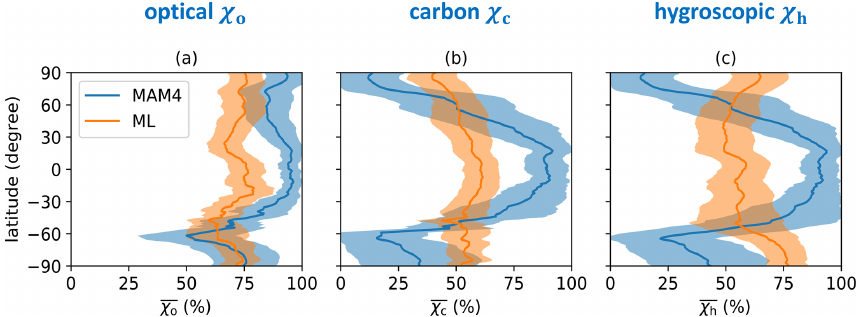
Figure 5. Zonal mean annual aerosol mixing state indices (a) χ o , (b) χ c , and (c) χ h using the MAM4 model and ML model. The bands refer to the standard